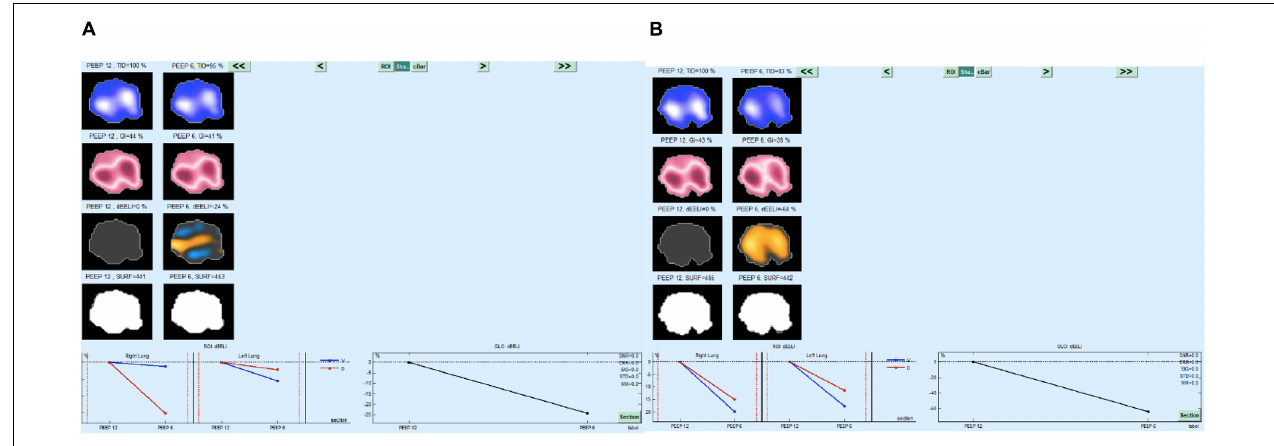
FIGURE 5 | EITdiag MatLAb Analysis of the decremental CPAP trial in a patient who died, (A) supine, (B) prone. Note the (cid:49) EELI% < 40 in supine postion and > 50 in prone